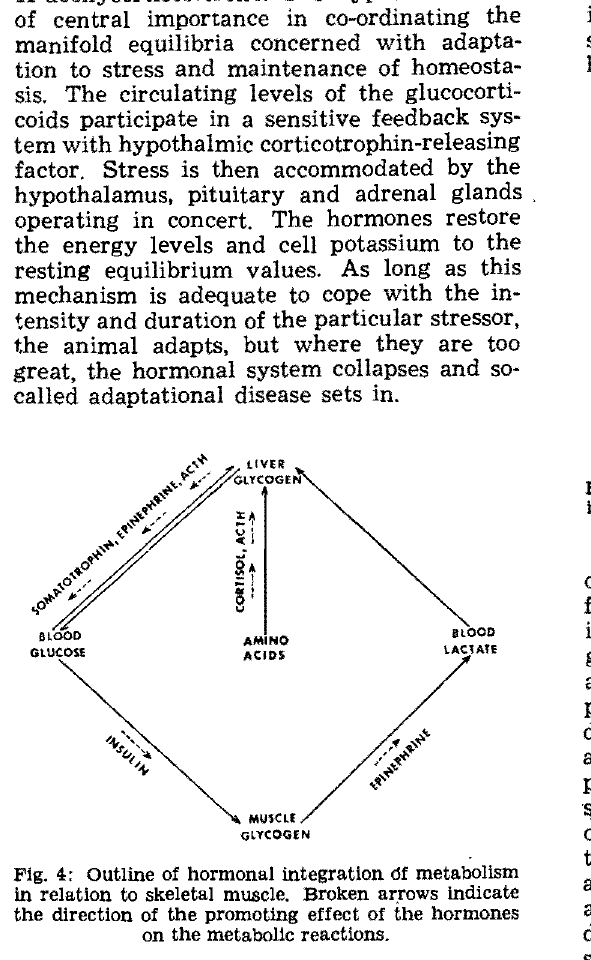
Fig. 4: Outline of hormonal integration df metabolism in relation to skeletal muscle. Broken arrows indicate the direction of the promoting effect of the hormones on the metabol1c reactions.